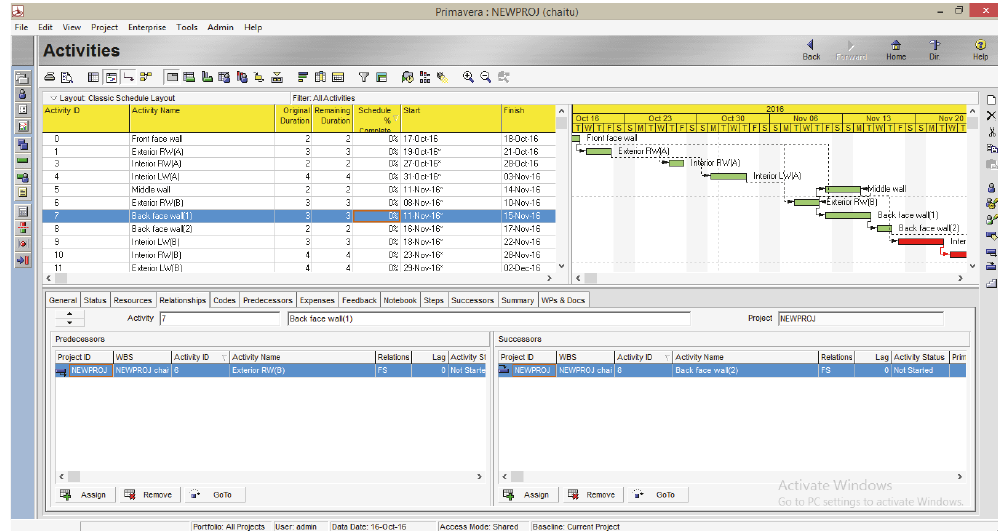
Figure 3: PRIMAVERA generated